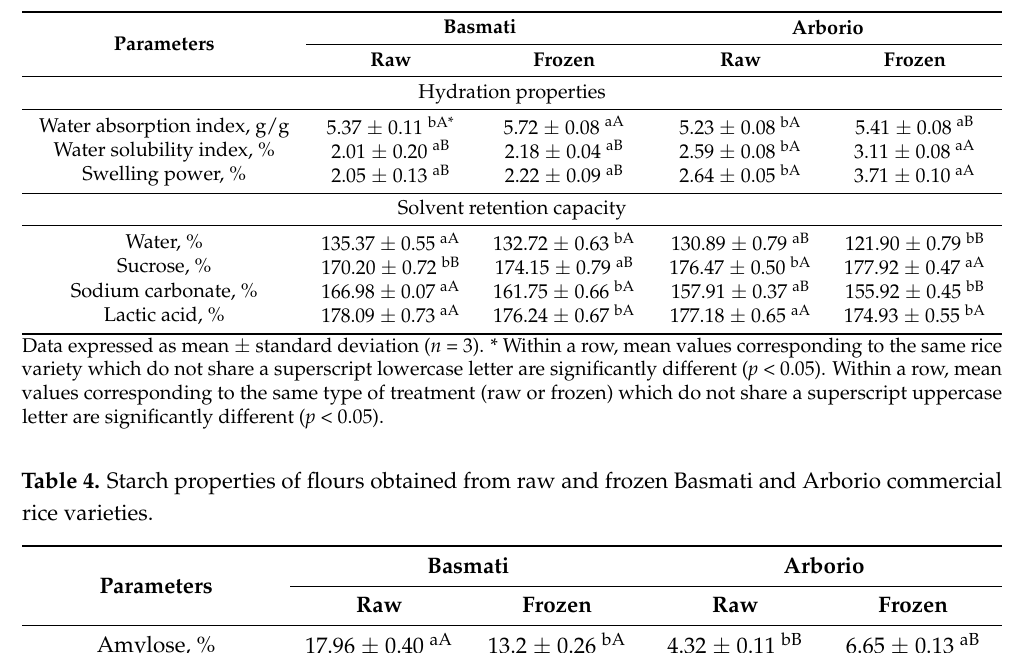
Table 3. Functional properties of flours obtained from raw and frozen Basmati and Arborio rice.